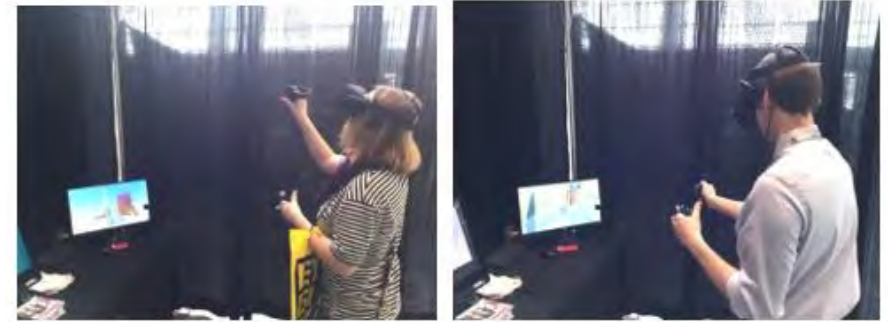
Figure 7. Kitoparts testersat the 2017 East Coast Games Conference in Raleigh,